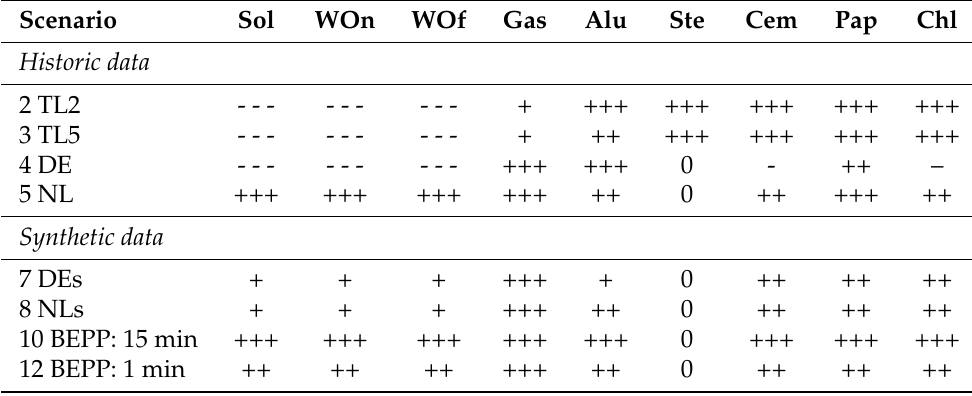
Table 13. Overview of the technologies’ profit in the investigated scenarios. Scenario Sol WOn WOf